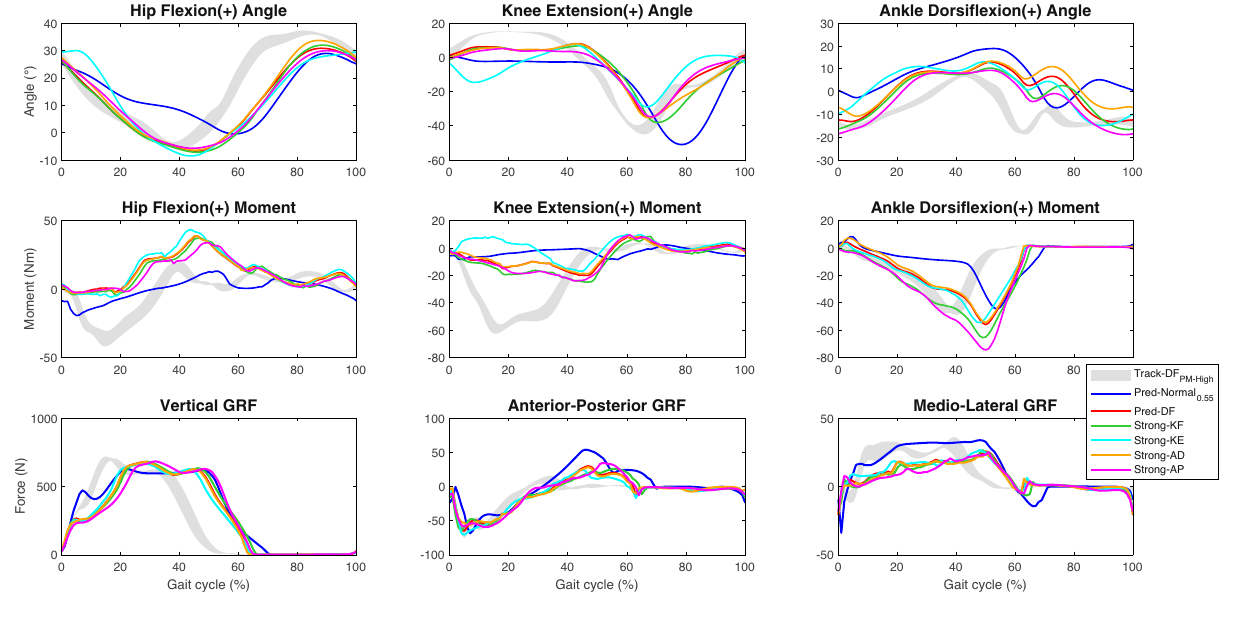
Figure 2. Influence of altered muscle–tendon parameters on Track-DF PM-High (mean ± standard deviation), Pred-Normal 0.55 , Pred-DF, and Strong gait (ipsilateral hip, knee, and ankle angles, moments, and GRF). All simulations were performed at 0.55 m/s.